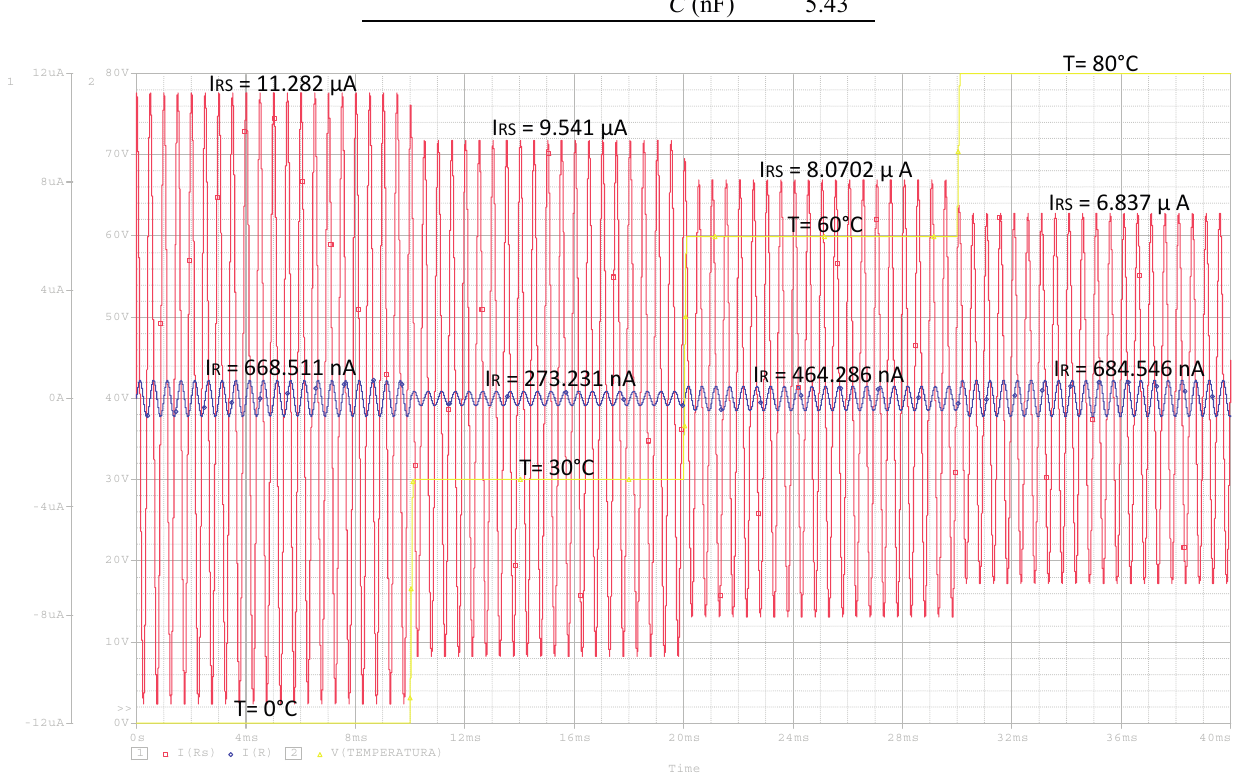
Figure 10. Response of the electrical current through resistance R S (red line) and R (blue line) as a function of the time, while the temperature increases from 0 to 80 °C (yellow line), for the homeotropic MLC-6290